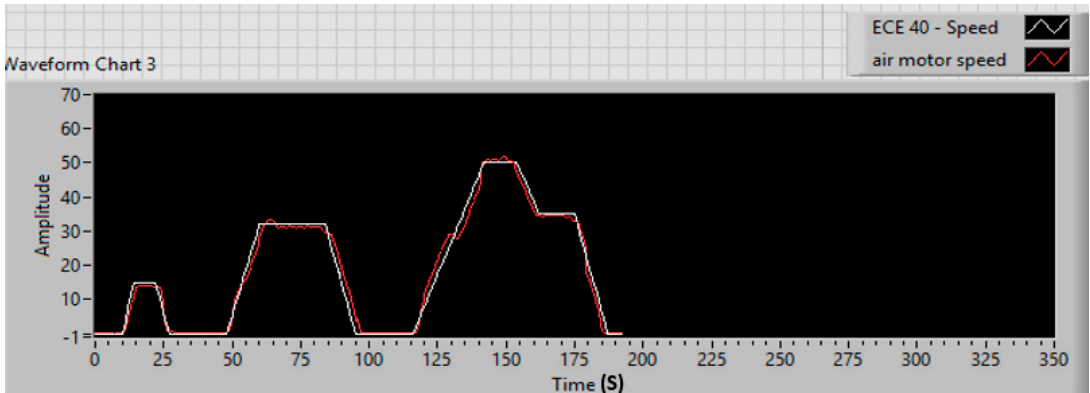
Figure 10. Relationship between the volume of the electric valve and driving time of the emissions standards of Economic Commission for Europe (ECE 40).